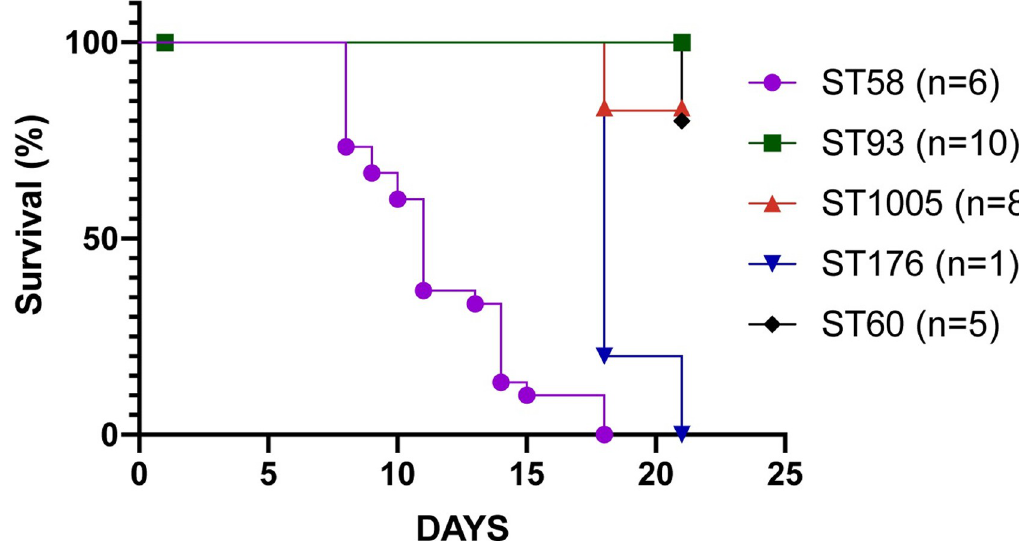
Fig 5. A kill curve based on subcutaneous injection of 500 CFUs in 5 mice for each isolate. The mortality curves were plotted in Prism. For each ST, all mice were pooled, and mortality curves plotted. Raw survival data per isolate is shown in S3